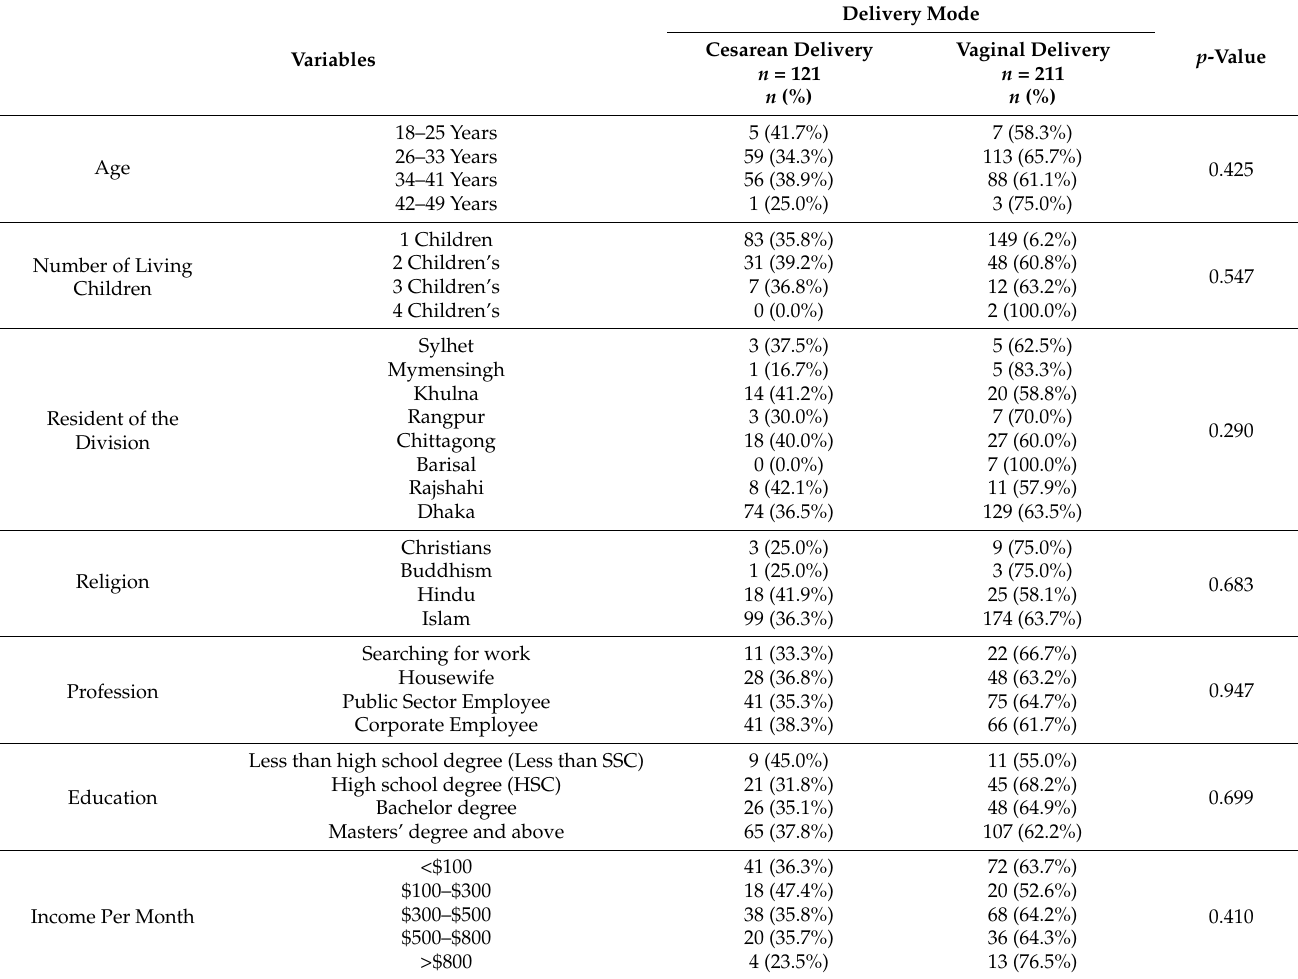
Table 1. Mothers’ demographic characteristics in respect to delivery mode (N =